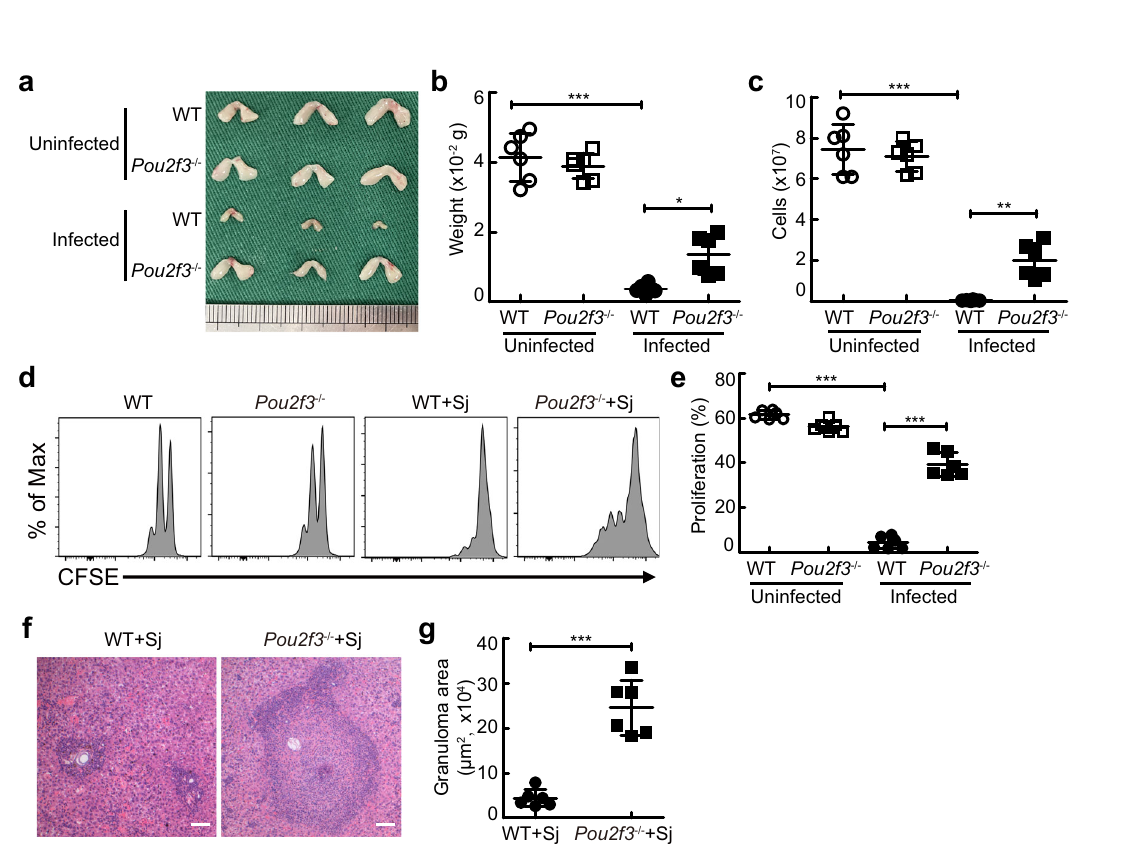
Fig. 8 | Pou2f3 de fi ciency abolishes thymic involution-mediated T cell aging during schistosome infection. a – c Representative morphology and quanti fi ed weight and cellularity of thymus from WT or Pou2f3 − / − mice 8 weeks after schisto- some infection ( n =6 mice, pool of two independent experiments). Infected WT versus Uninfected WT, P <0.0001 (weight), P <0.0001 (cells); Infected WT versus Infected Pou2f3 − / − , P =0.0112 (weight), P =0.0031 (cells); One-way ANOVA with Tukey ’ s multiple comparisons. d , e Representative and quanti fi ed fl ow